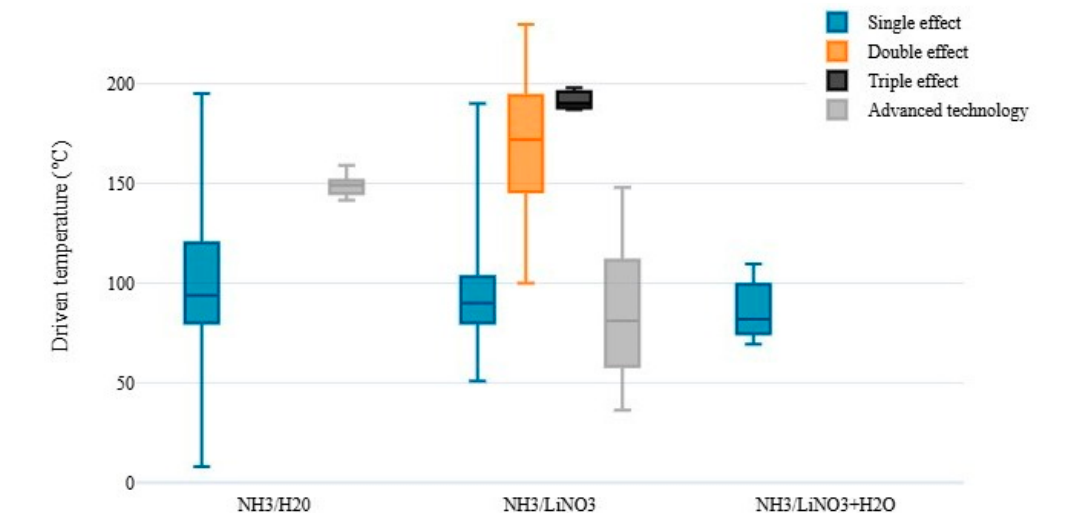
Figure 18. Summary of the driving temperature for each of the three working fluids (NH 3 /H 2 O, NH 3 /LiNO 3 , and NH 3 /LiNO 3 + H 2 O) for each of the four technologies (single, double, triple, and advanced technology).